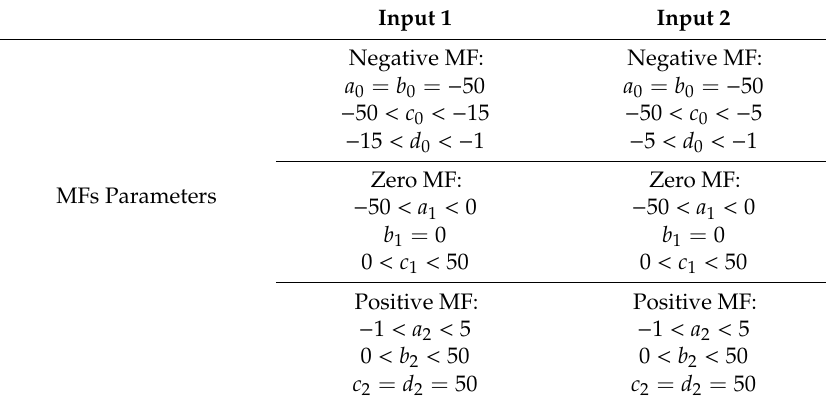
Table 9. Limits of the parameters of the membership functions.